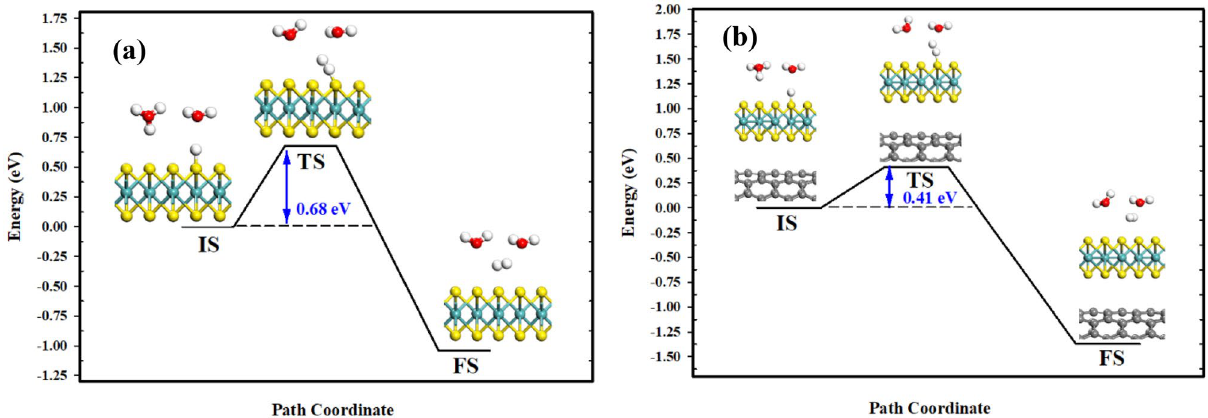
Figure 6. Minimum-energy pathway of the Heyrovsky reaction on: ( a ) MoS 2 ; and ( b ) MoS 2 /CNT heterostructure. BIOVIA, Dassault Systèmes, Materials Studio, version 7. https ://bit.ly/38lRR QR.